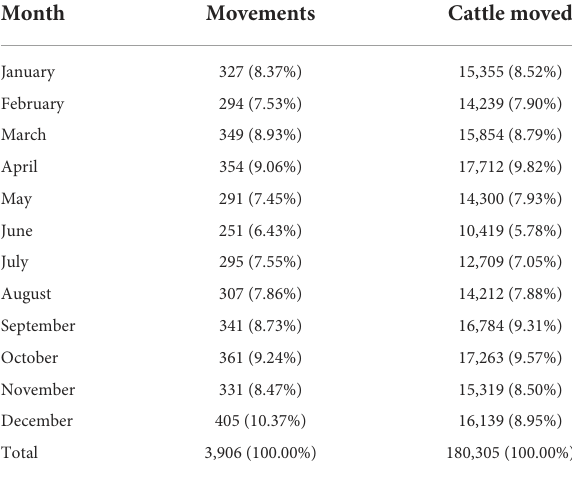
TABLE 2 Distribution of dairy cattle moved (animal head) and movements (frequency) between districts in northern Thailand from 2010 to 2017 stratified by